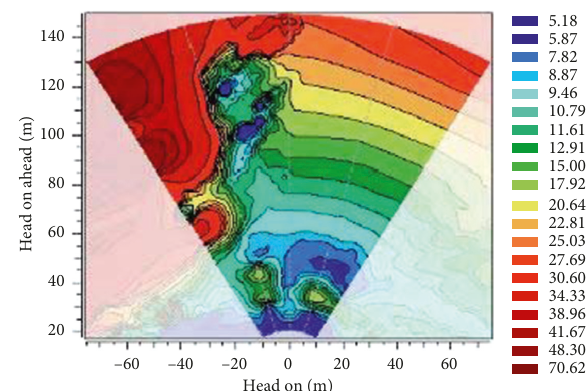
Figure 22: Contour of apparent resistivity of rock wall before blasting at 800m of B3 track